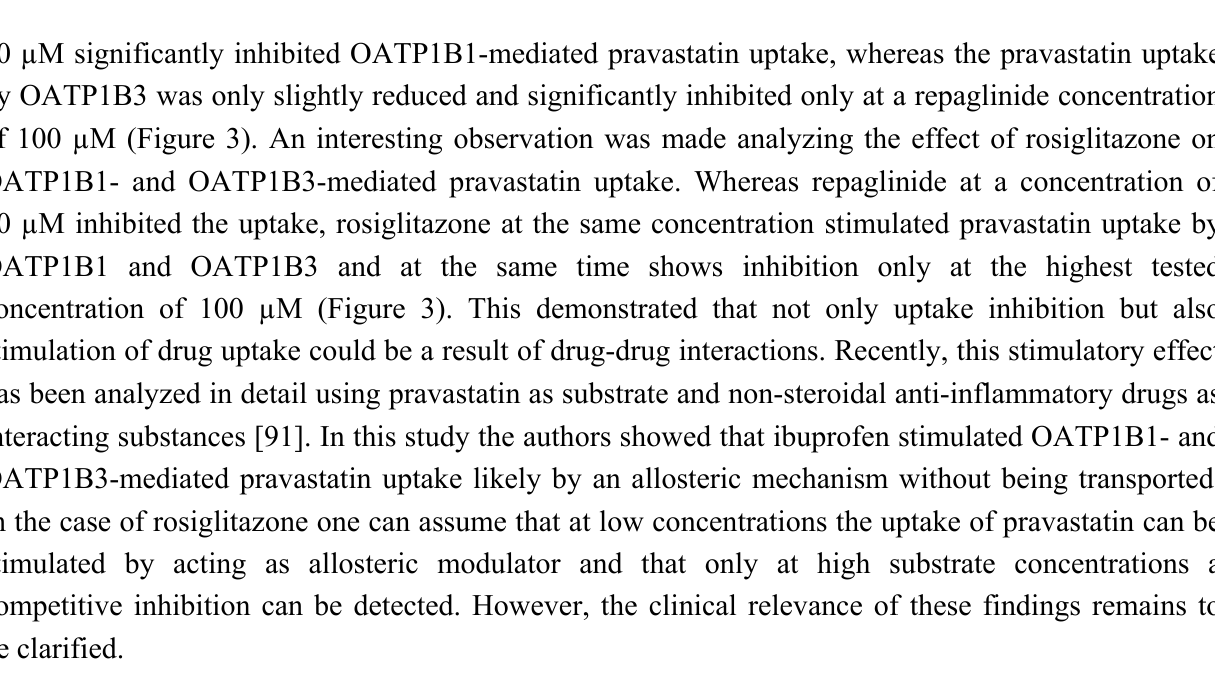
Figure 2. Inhibition of OATP1B1- (top), OATP1B3- (middle) and OATP2B1-mediated (bottom) BSP uptake by the oral antidiabetic drugs rosiglitazone (left) and repaglinide (right). Data are shown as the percentage of BSP uptake (0.05 µM BSP for OATP1B1- and 1 µM BSP for OATP1B3- and OATP2B1-mediated transport; modified from [64]) in the absence of the respective